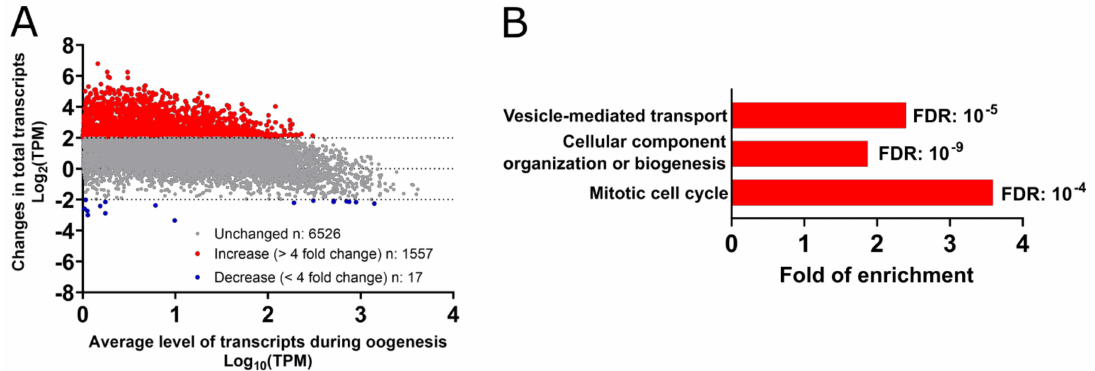
Figure 2. Changes in the total mRNA level during the growth period. ( A ) Changes in mRNA levels between stages I–II (starting of the growth period) and stages V–VI (end of the growth period) have been plotted. ( B ) Selection of the gene ontology terms enriched among the 1557 transcripts whose levels increase during the growth